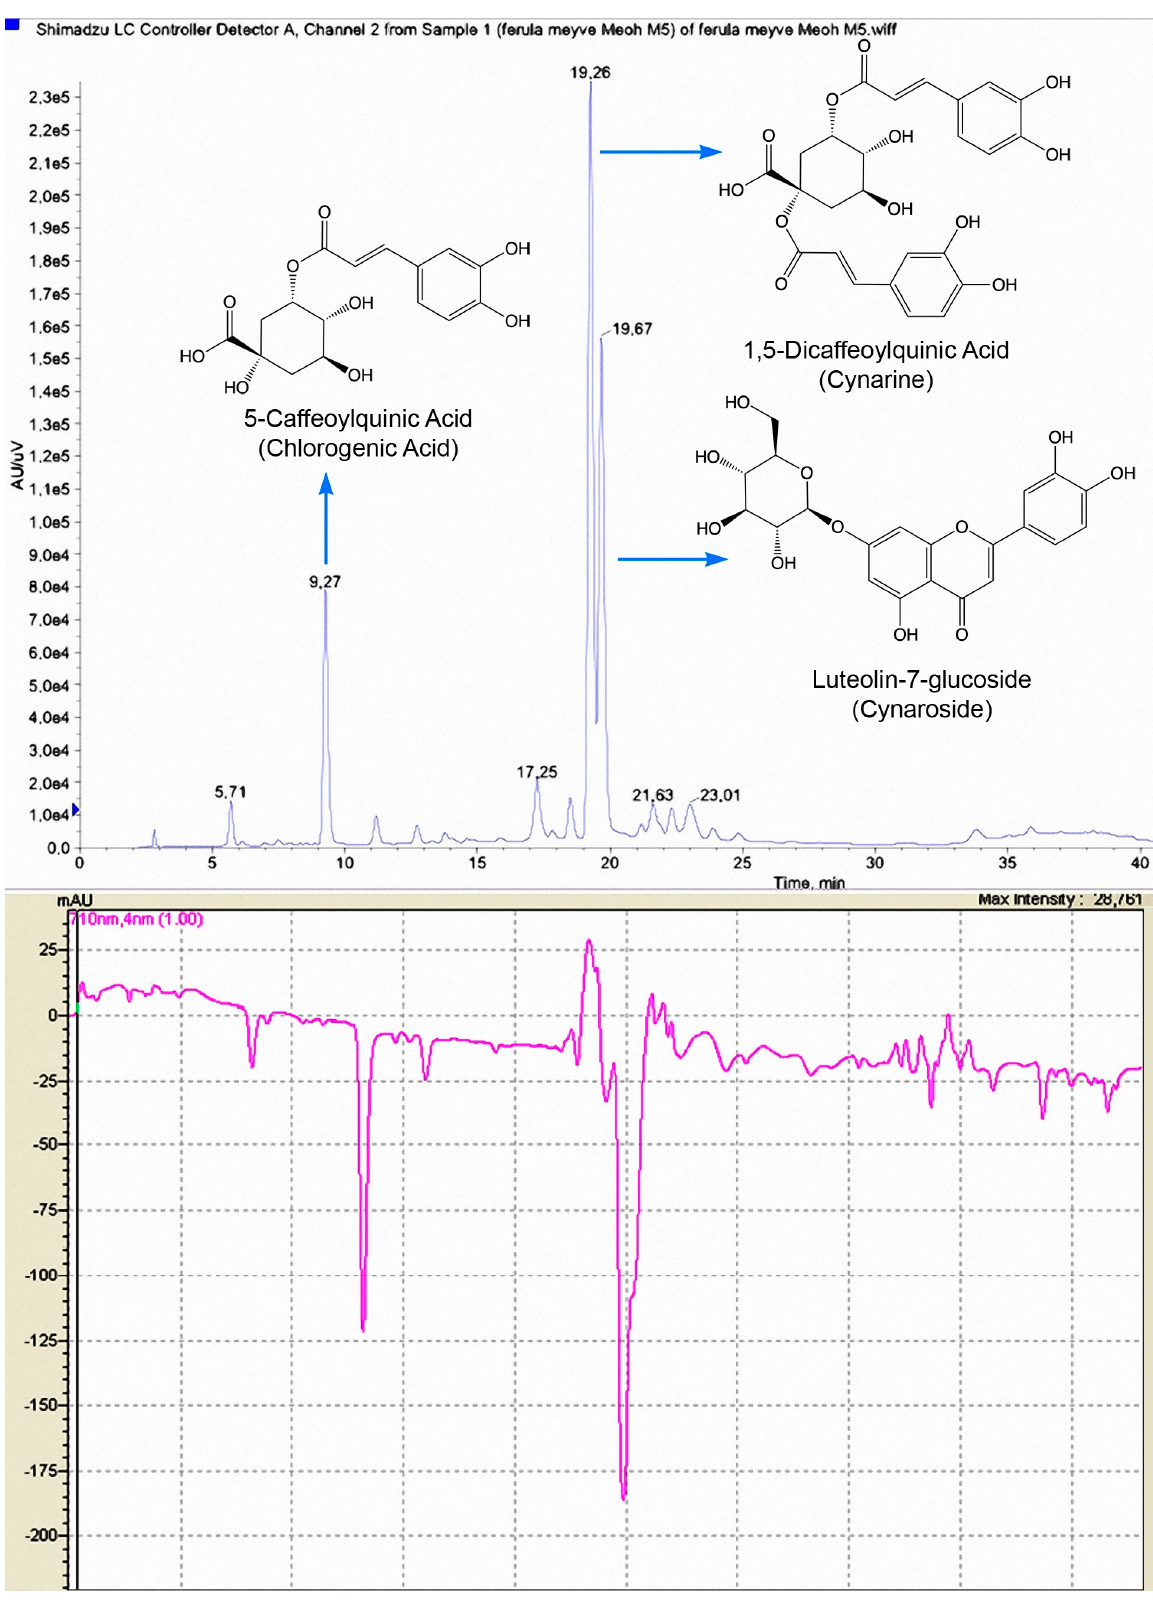
Figure 4. Online HPLC–ABTS •+ chromatogram (lower section) of the methanolic extract of fruits of Ferula drudeana display negative peaks, indicating the antioxidant activity of the corresponding compound peaks in the upper HPLC chromatogram.